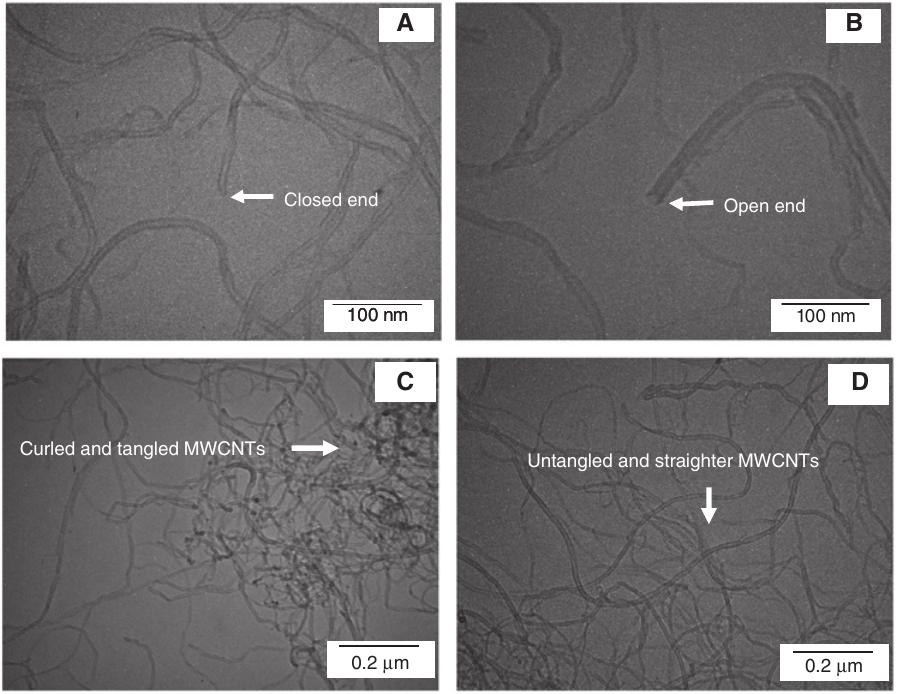
Figure 1 TEM images of fragmented (A) pristine MWCNTs and (B) acid-treated MWCNTs, and complete (C) pristine MWCNTs and (D) acid-treated